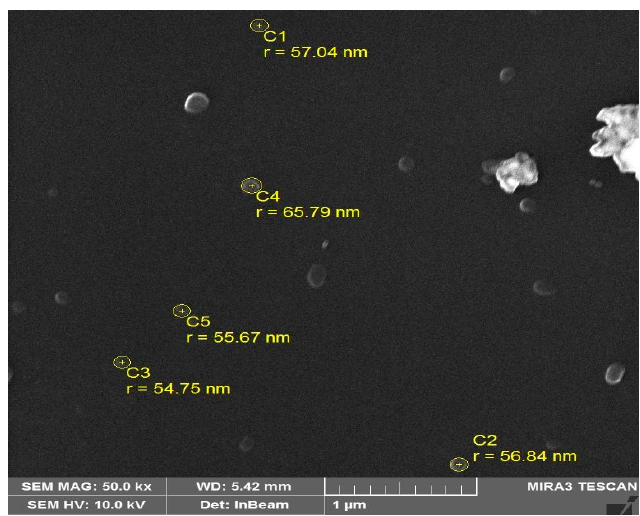
Figure 4. FESEM image of as-synthesized Ag nanoparticles.